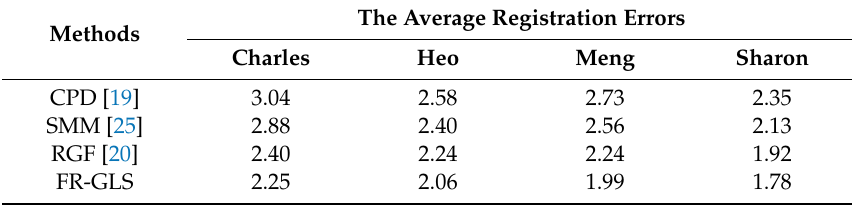
Table 1. The average registration errors comparison of CPD, SMM, RGF and our FR-GLS method on four typical individuals in Figure 4.